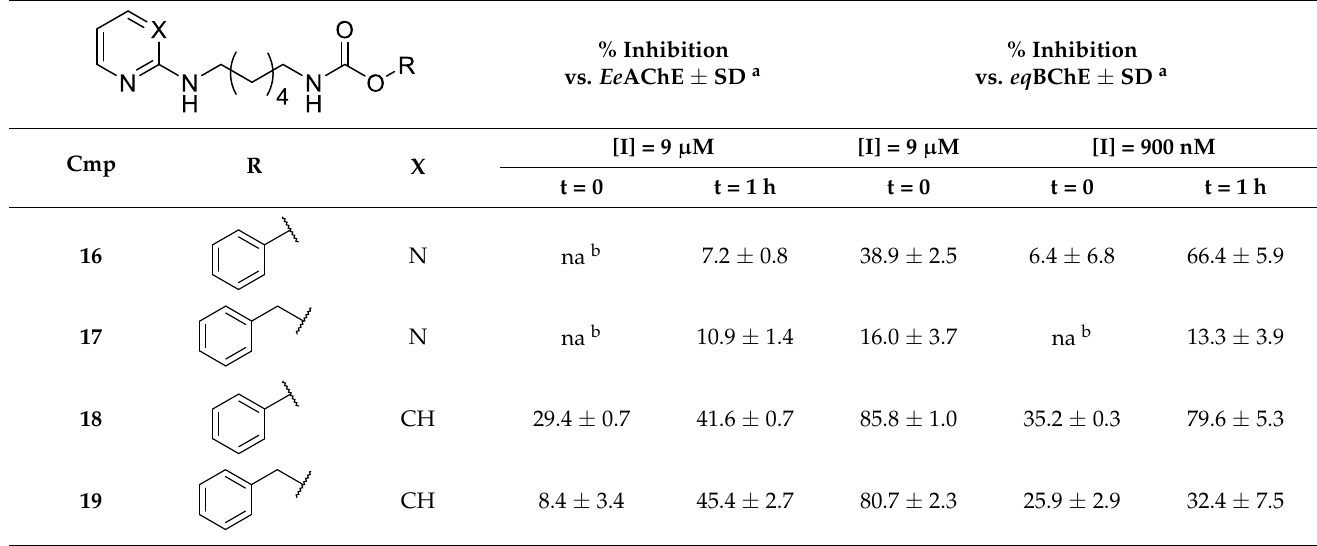
Table 2. Inhibition of Ee AChE and eq BChE activities by pyrimidine and pyridine carbamate deriv- atives 16 – 19 .